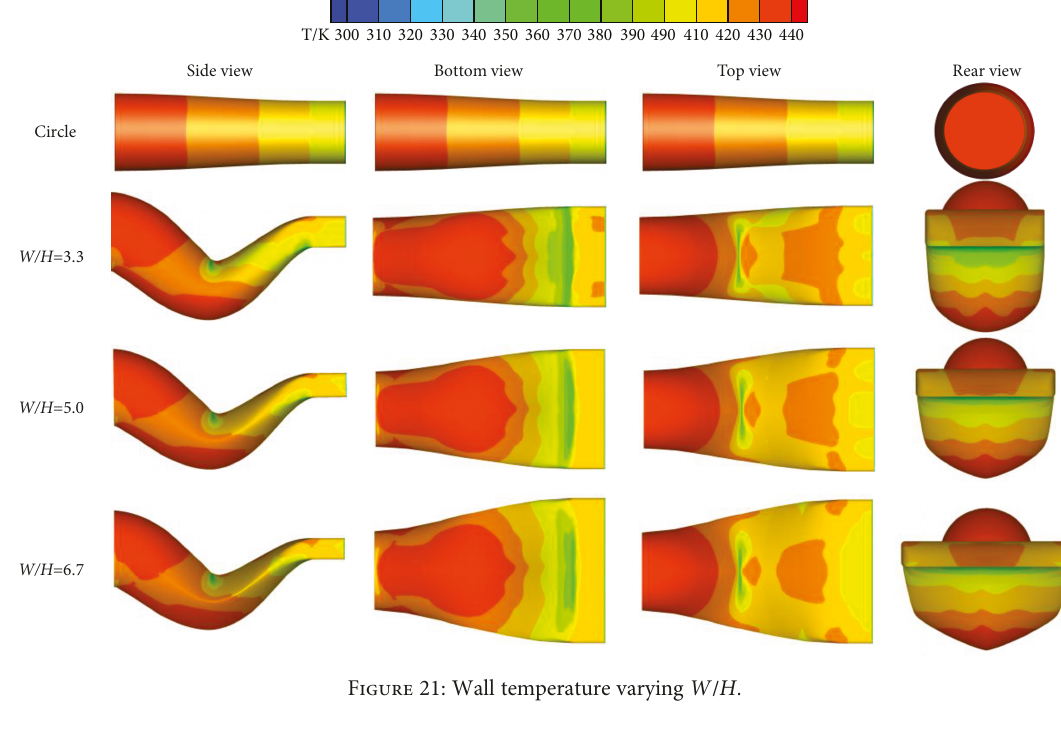
Figure 21: Wall temperature varying W / H .